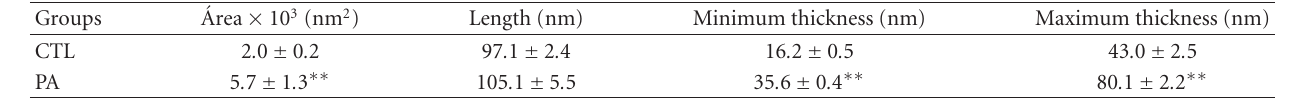
Table 2: Analysis of PSDs features in CA1 hippocampal area.